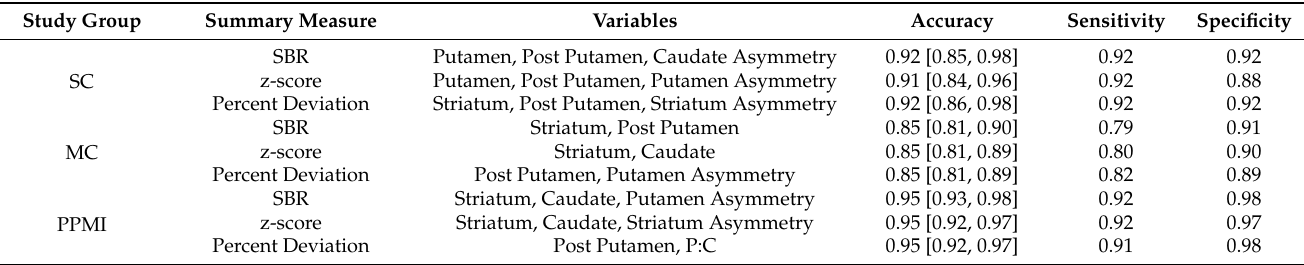
Table 3. Multi-variable results: The accuracy, sensitivity, and specificity for each group’s best multiple variable models, including three or fewer